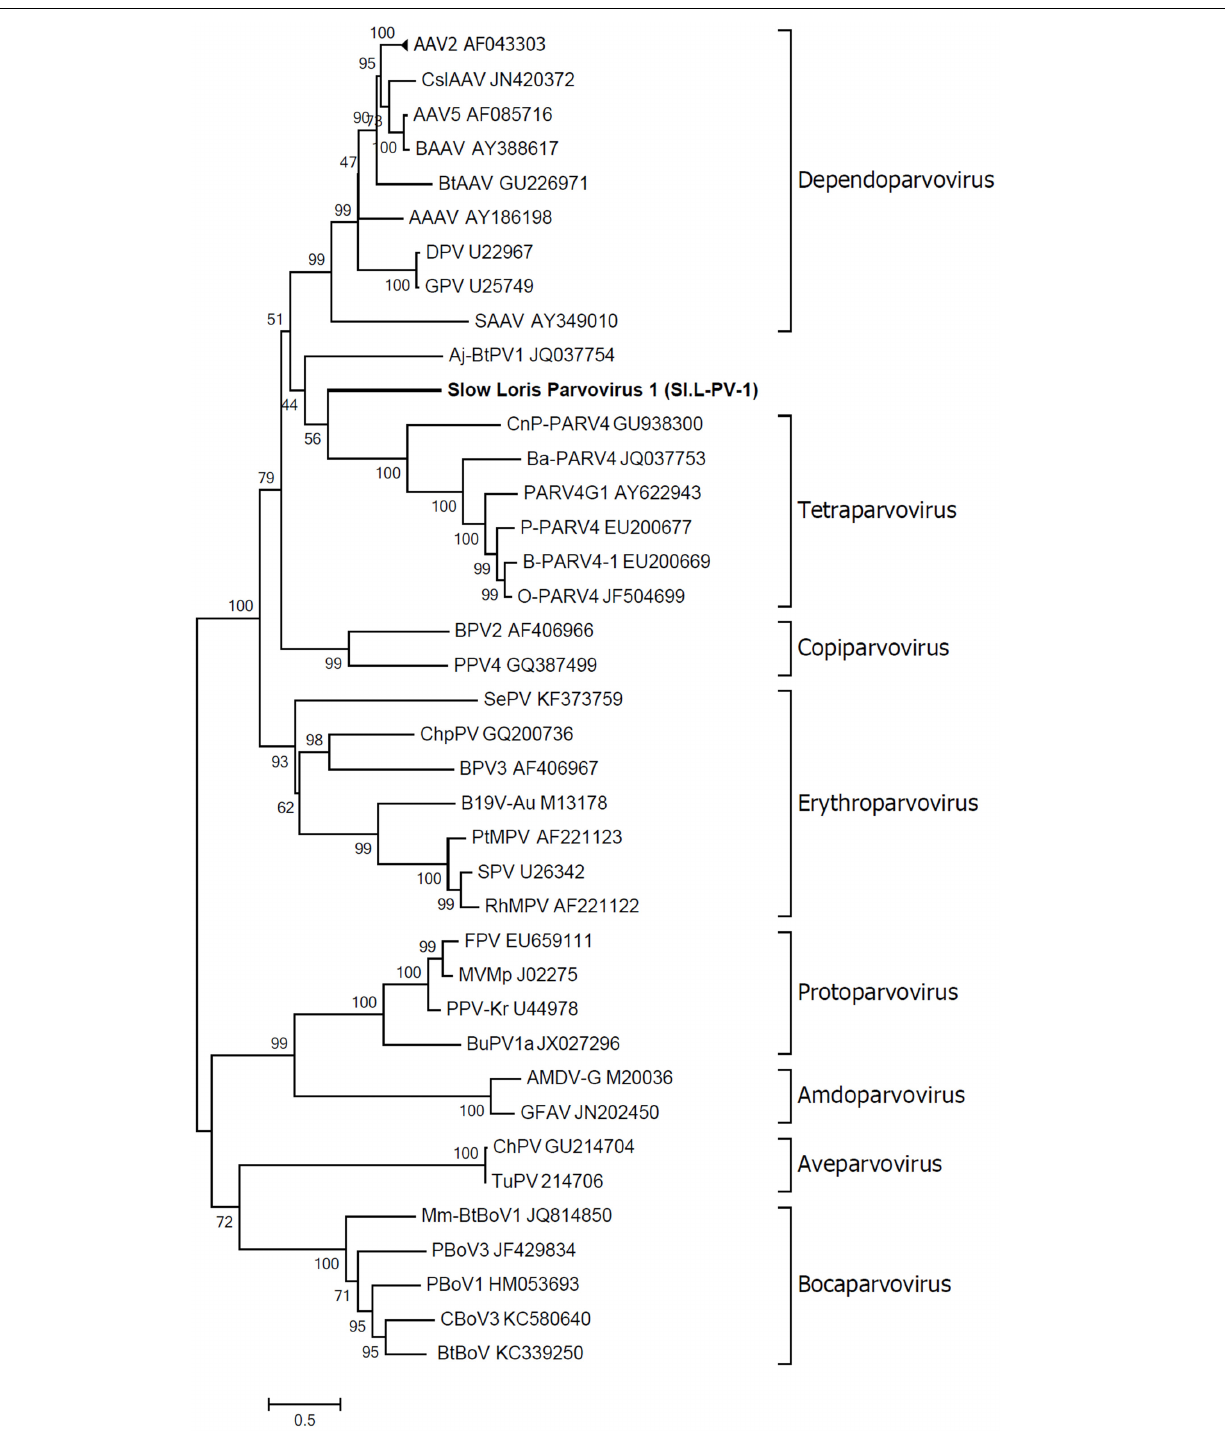
2.5202). The rate variation model allowed for some sites to be evolutionarily invariable ([ + I ], 4.0614% sites). All positions with less than 95% site coverage were eliminated. The outcome of the bootstrap analysis (Felsenstein, 1985) is shown next to the branches. The genera are designated by square brackets and the accession numbers of the reference strains are indicated next to the strain name. The virus described in this study is indicated in